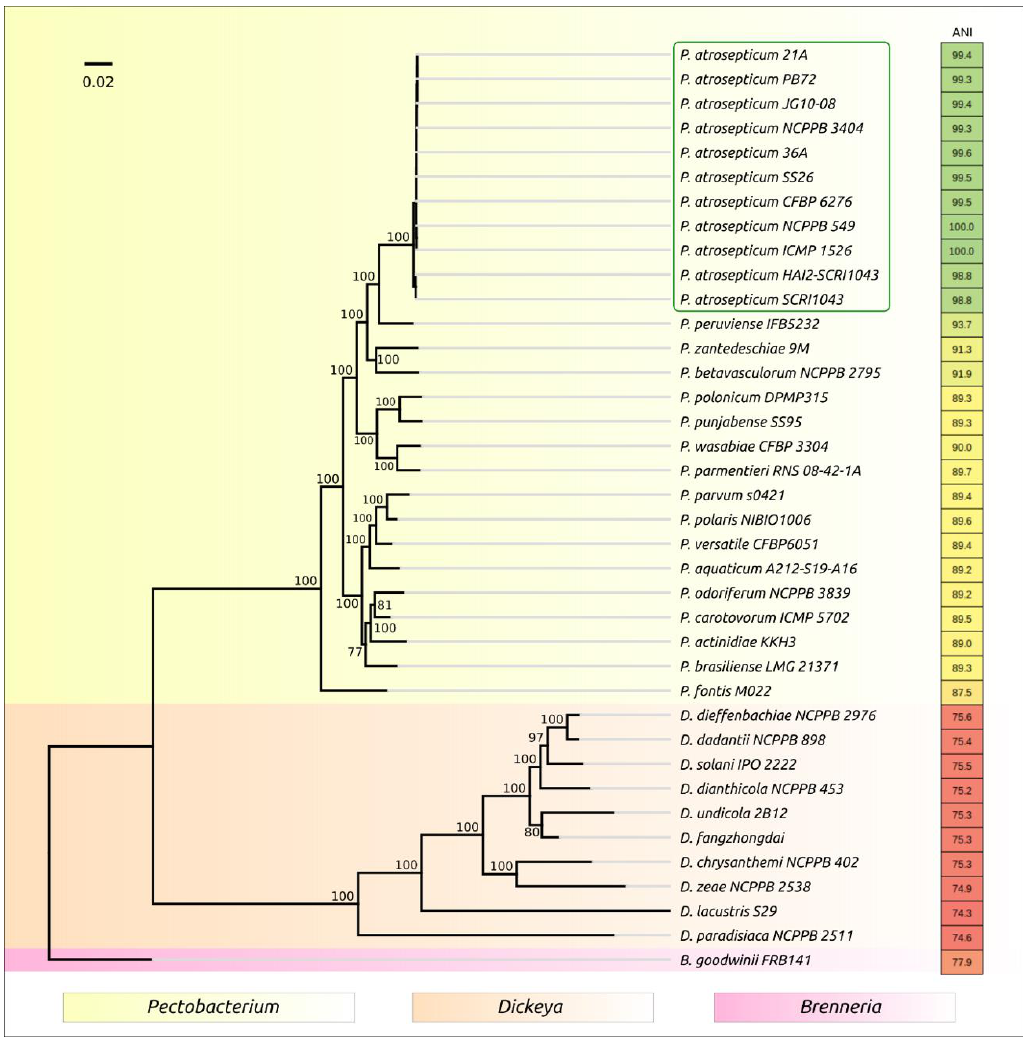
Figure 1. Best-scoring tree found by a maximum likelihood (ML) search with RAxML based on the 92 core genes concatenated nucleotide sequences. Gene sequences were extracted using the UBCG (up-to-date bacterial core gene) pipeline [27]. Bootstrap support values are shown above their branch as a percentage of 1000 replicates. The scale bar shows 0.02 estimated substitutions per site, and the tree was rooted to Brenneria goodwini FRB141. Average nucleotide identity (ANI) values compared to P. atrosepticum ICMP 1526 type strain were calculated with orthoANI [28] and are shown to the right of the organism name and colored according to a heat map scale, where a green color corresponds to the highest value and a red color corresponds to the lowest value.